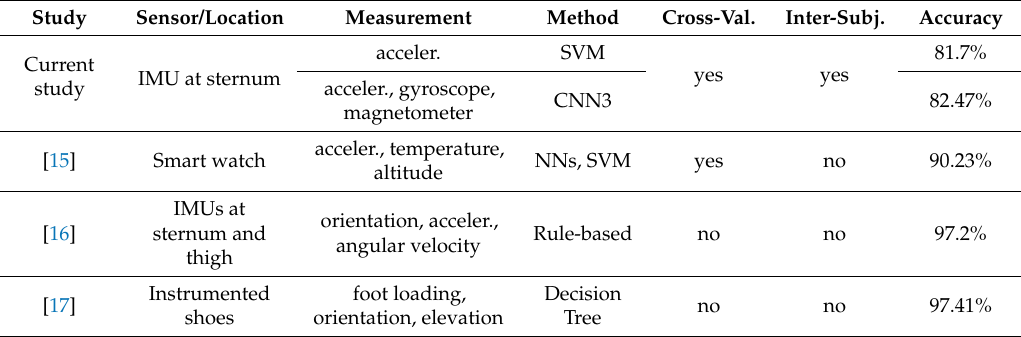
Table 6. Works on physical activity recognition of older people in real-world